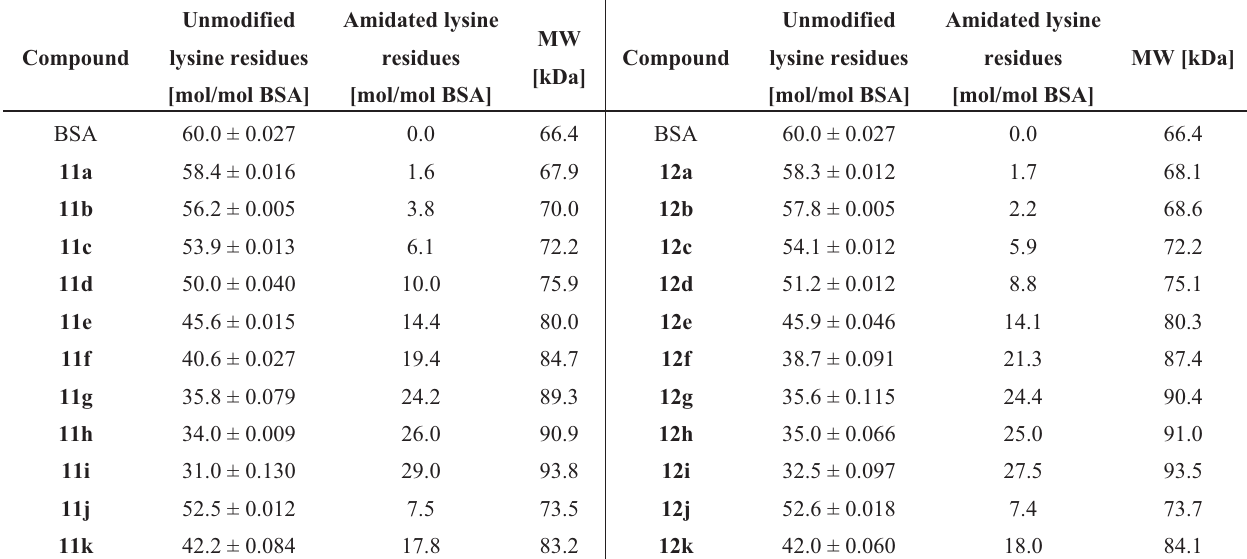
Table 1. Glycosylation densities and resulting molecular weights of BSA based neo-glycoproteins 11a – k and 12a – k . The molecular weights (MW) of BSA based neo-glycoproteins were calculated according to the number of attached LacNAc-LacNAc ( 11a – k ) and LacDiNAc-LacNAc ( 12a – k ) glycans using TNBSA assay.